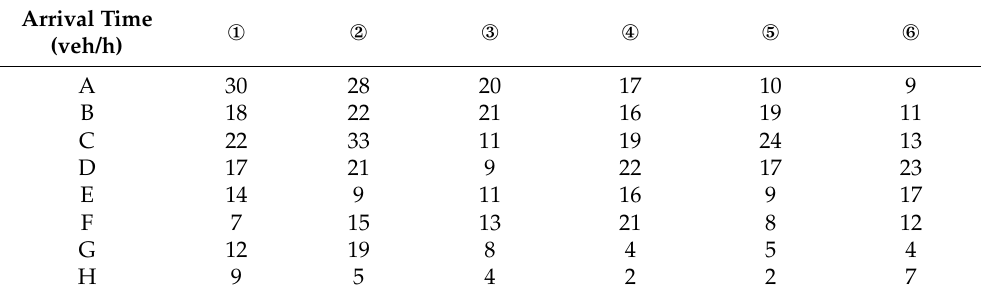
Figure 3. Presentation of the distribution in urban areas of the population in relation to the peak hour average. Table 2. Presentation of the arrival rates of freight transport vehicles in each logical station.